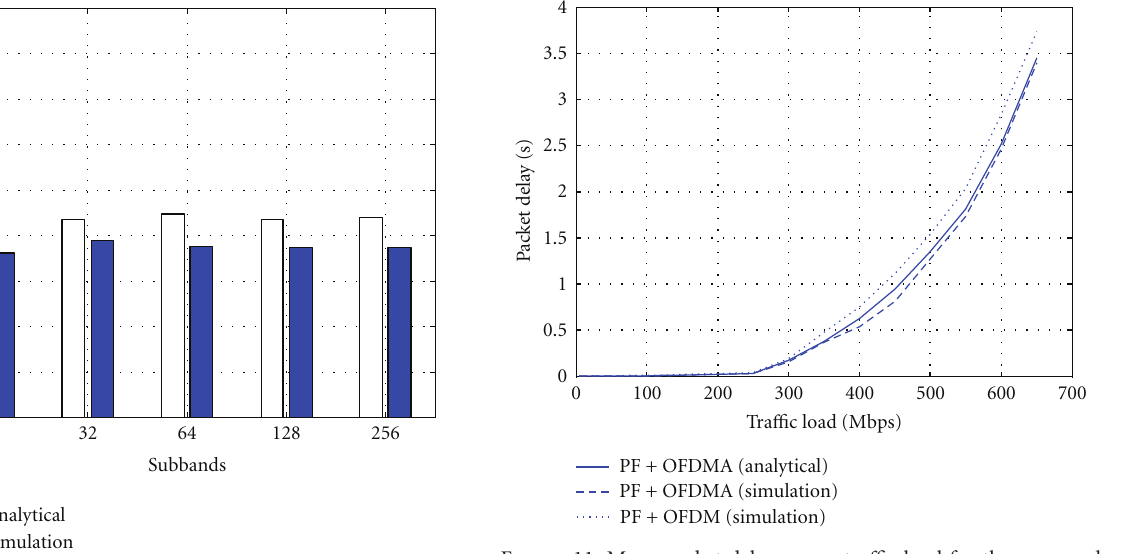
Figure 9: Jain’s fairness index versus the number of subbands (tra ffi c load = 250 Mbps).